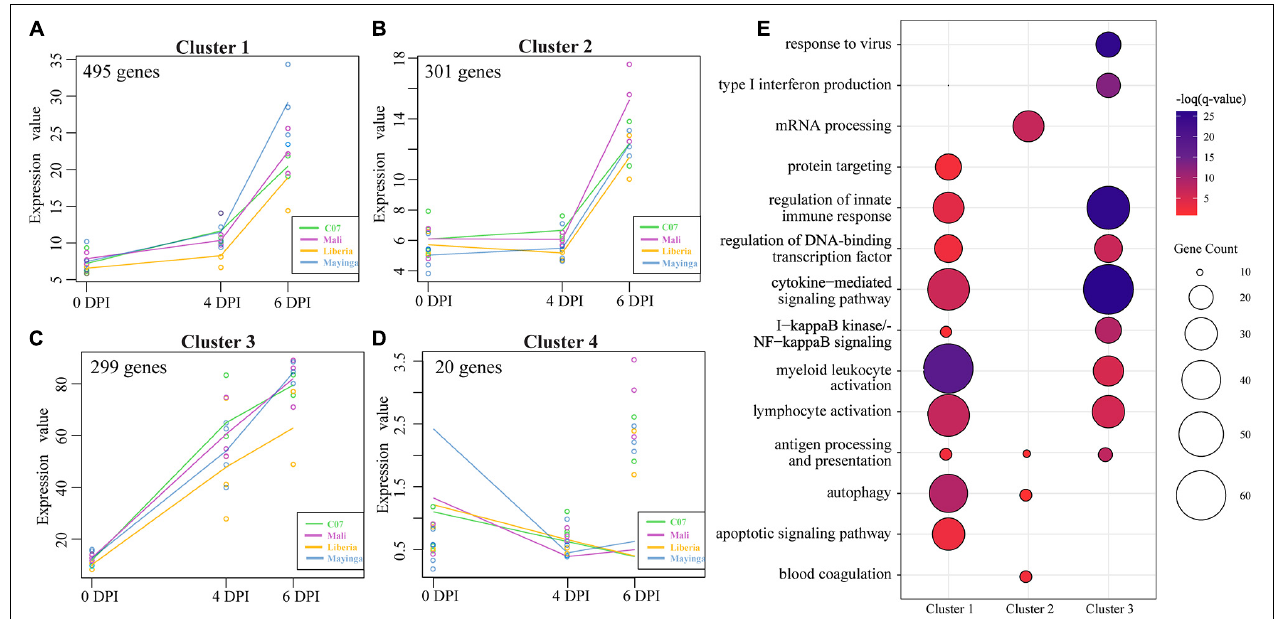
FIGURE 5 | MaSigPro, two-way forward regression analysis of EBOV-Makona and EBOV-Mayinga isolates. (A–D) Gene clusters 1–4 identified by MaSigPro. (E) Bubbleplot depicting functional enrichment of genes belonging to clusters 1, 2, and 3. The size of the bubble represents the number of DEGs, while the color represents the –log( q